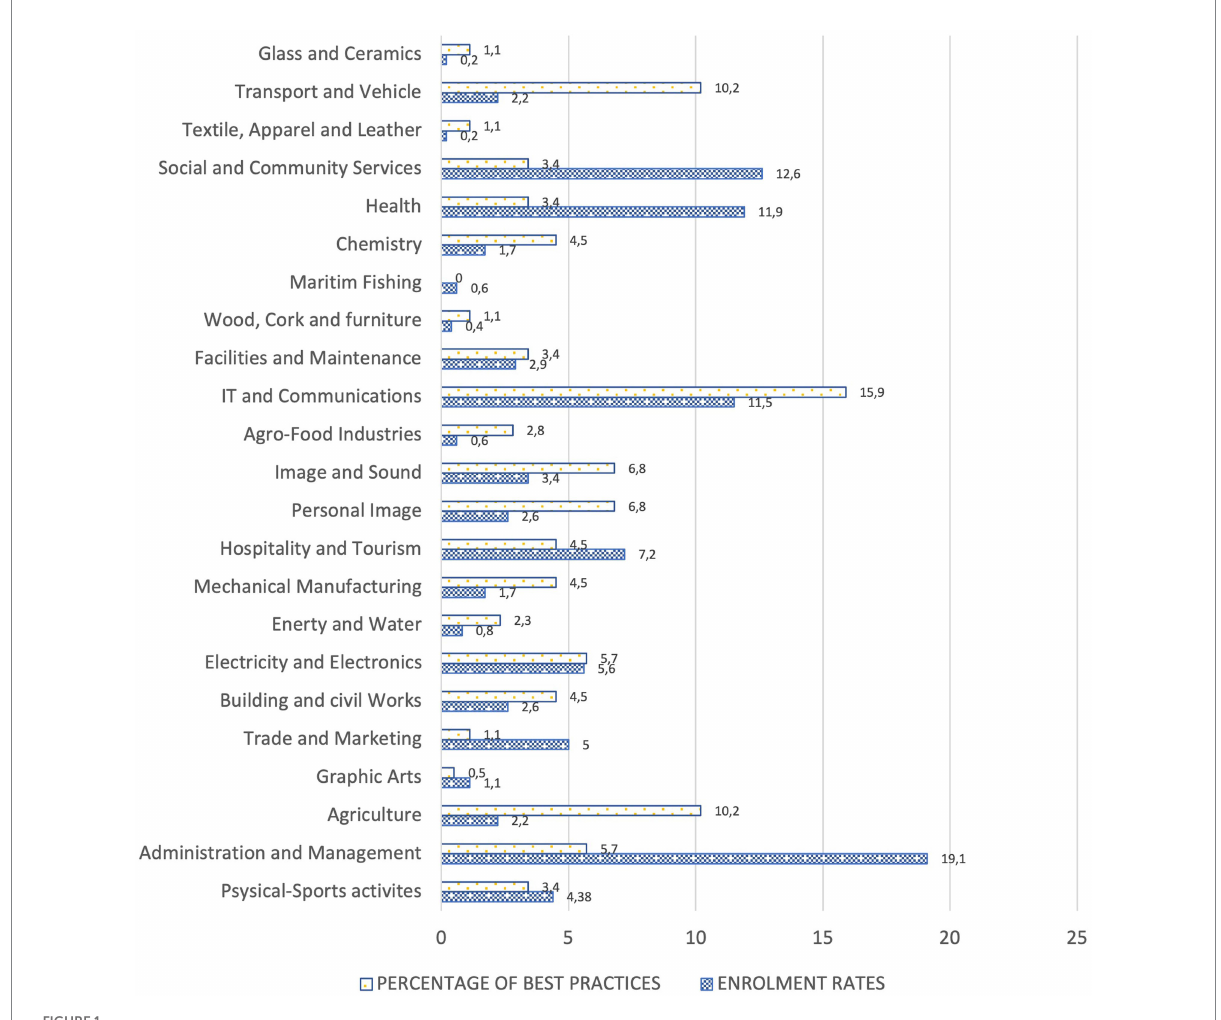
FIGURE 1 Enrolment rates and percentage of best practices by professional